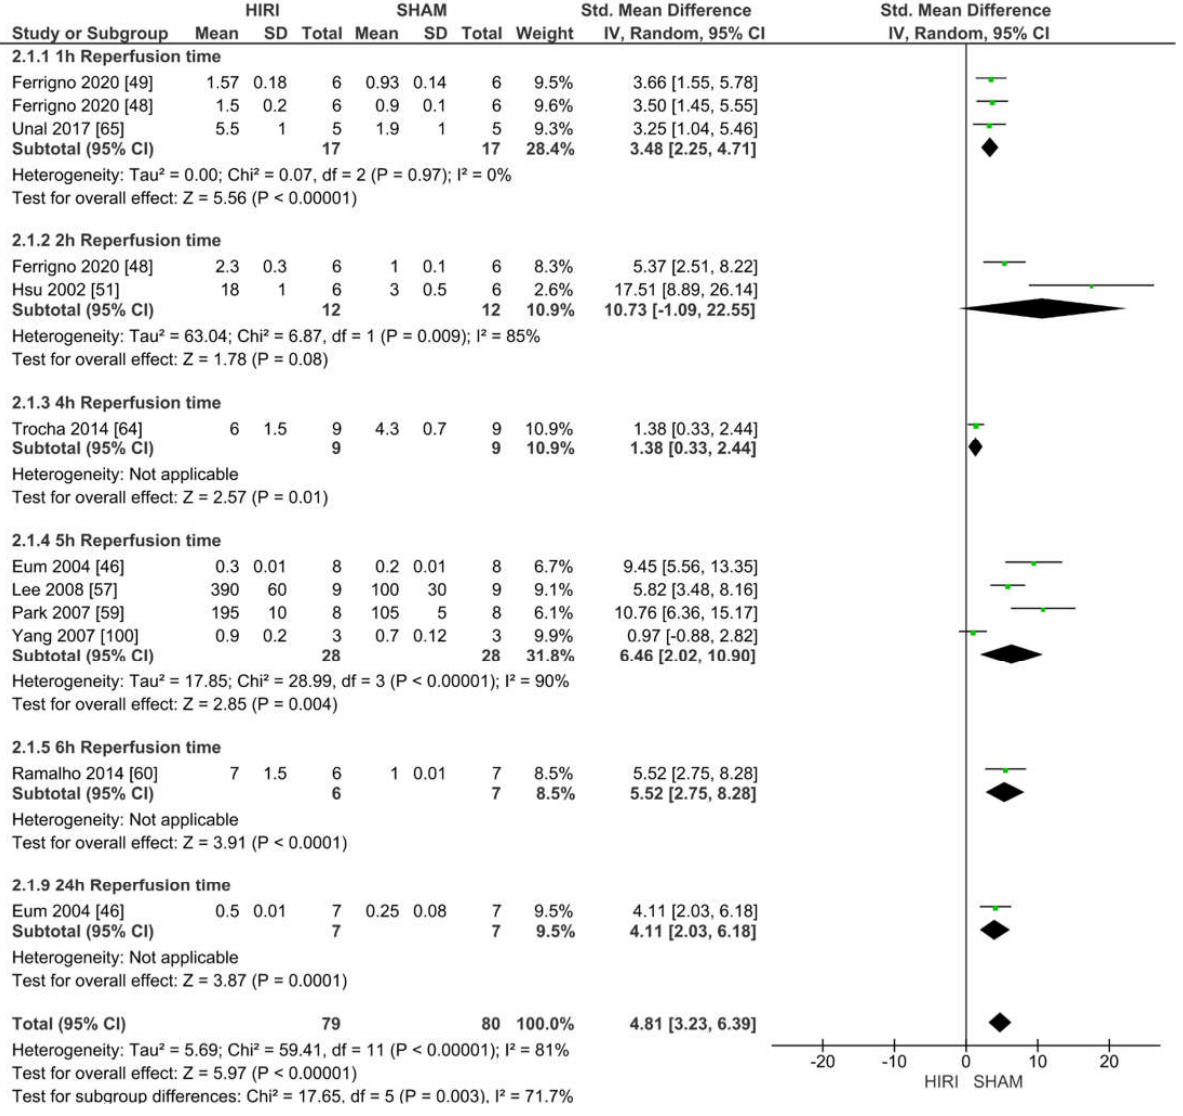
Figure 8. Forest plot of 70% HIRI in rats and 60 min warm ischaemia time grouped by reperfusion time between 1 and 24 h.